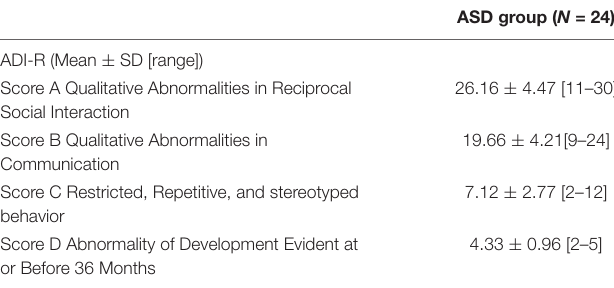
TABLE 2 | ADI-R domain-specific